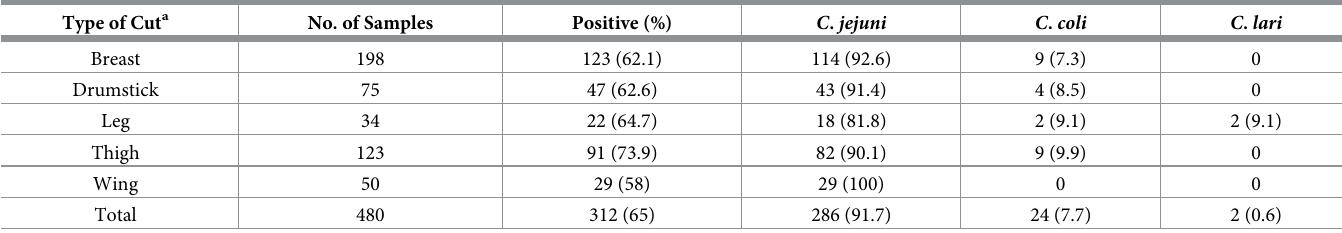
Table 1. The total number (%) of Campylobacter spp. recovered from each of the major types of retail poultry cuts tested. Type of Cut